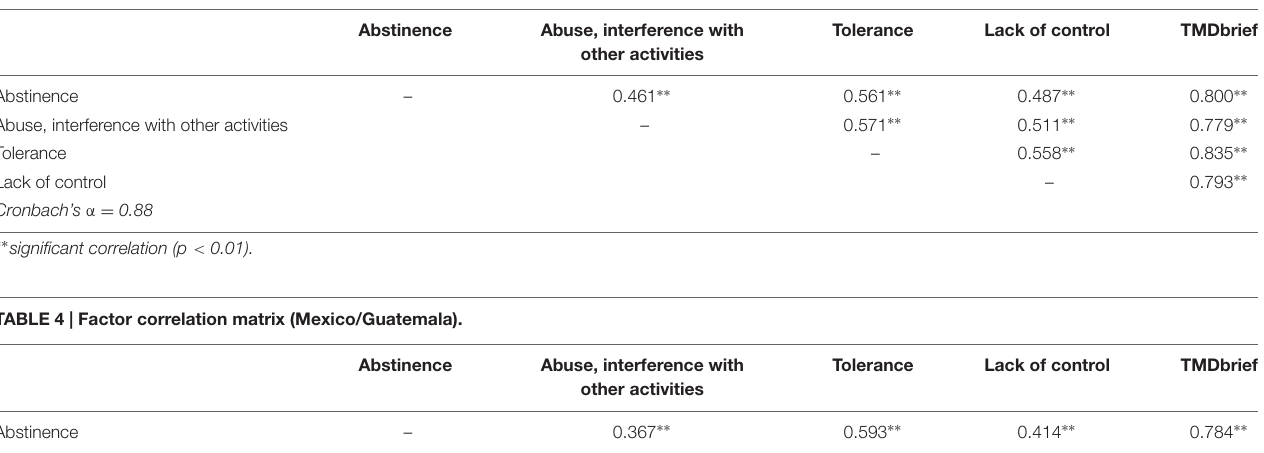
TABLE 3 | Factor correlation matrix (Spain).